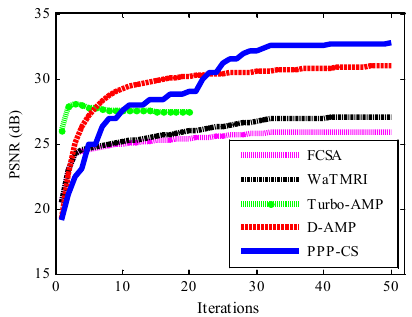
Figure 7. Performance comparison (iterations vs. PSNR) on “Cameraman” with 20% sampling.